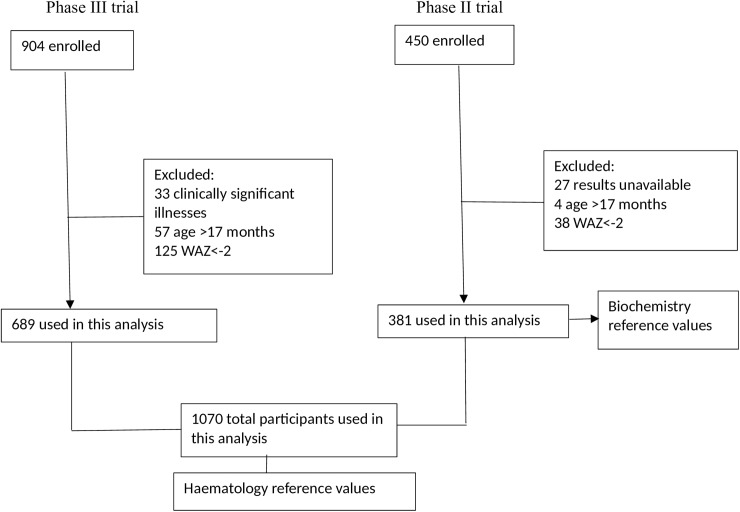
Participant flow diagram.